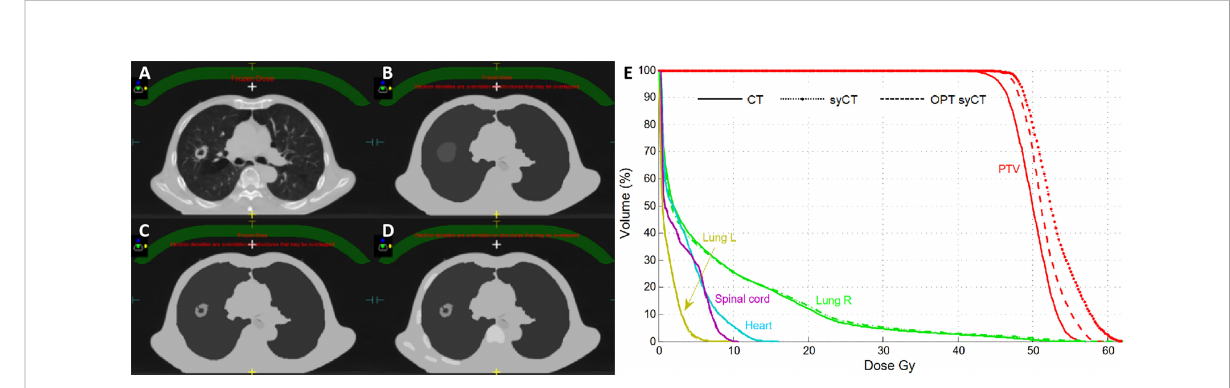
FIGURE 2 Successive attempts to realign the CT and syCT plan dosimetries for lung case 1. Reference CT representative transversal image (A) , corresponding syCT with ED assignments on successive attempts (B – D) , and corresponding DVHs (E) .